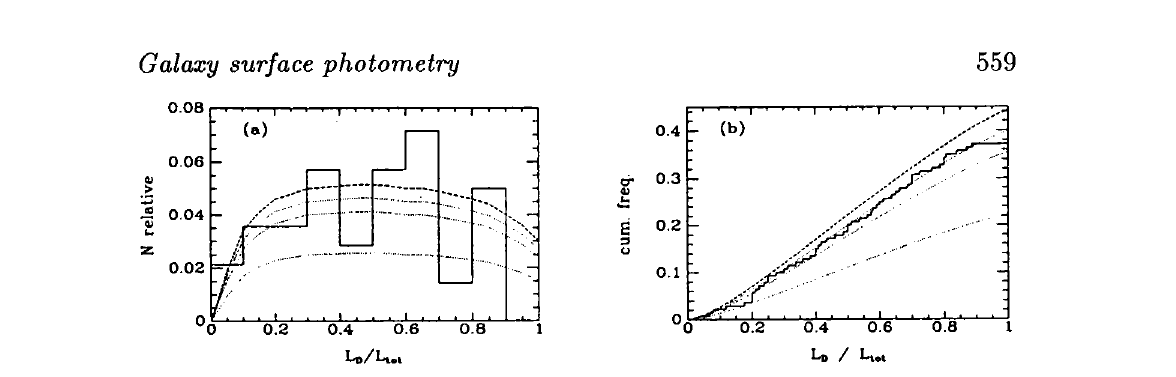
Fig. 12. Relative (a) and cumulative (b) frequency for the relative disk luminosities. Solid line - determinations from the e2i.85 - (c4) dia- gram. The distribution has been normalized with the total number of galaxies fainter than mx = 12™7. Dashed line - model prediction for a uniform intrinsic distribution, corrected for the incompleteness due to the limits enforced on 621.85 a n d (c4). Dotted lines - model predictions for a uniform intrinsic distribution plus a fraction of diskless galaxies. Models for fractions of 0.1, 0.2, and 0.5 are shown. A higher fraction of diskless galaxies moves the curve for the normalized distribution downwards in both (a) and (b). (From